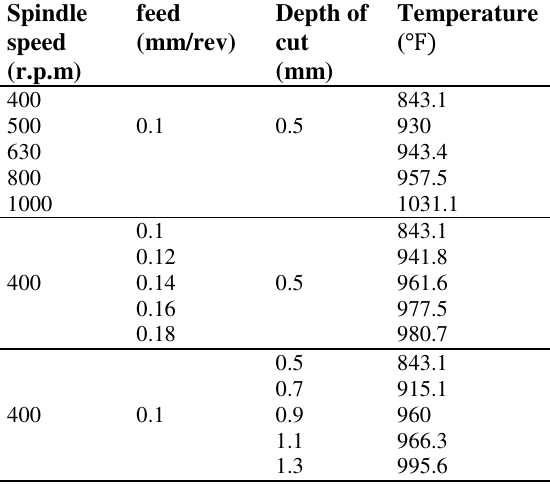
Cutting parameters and experimental results of